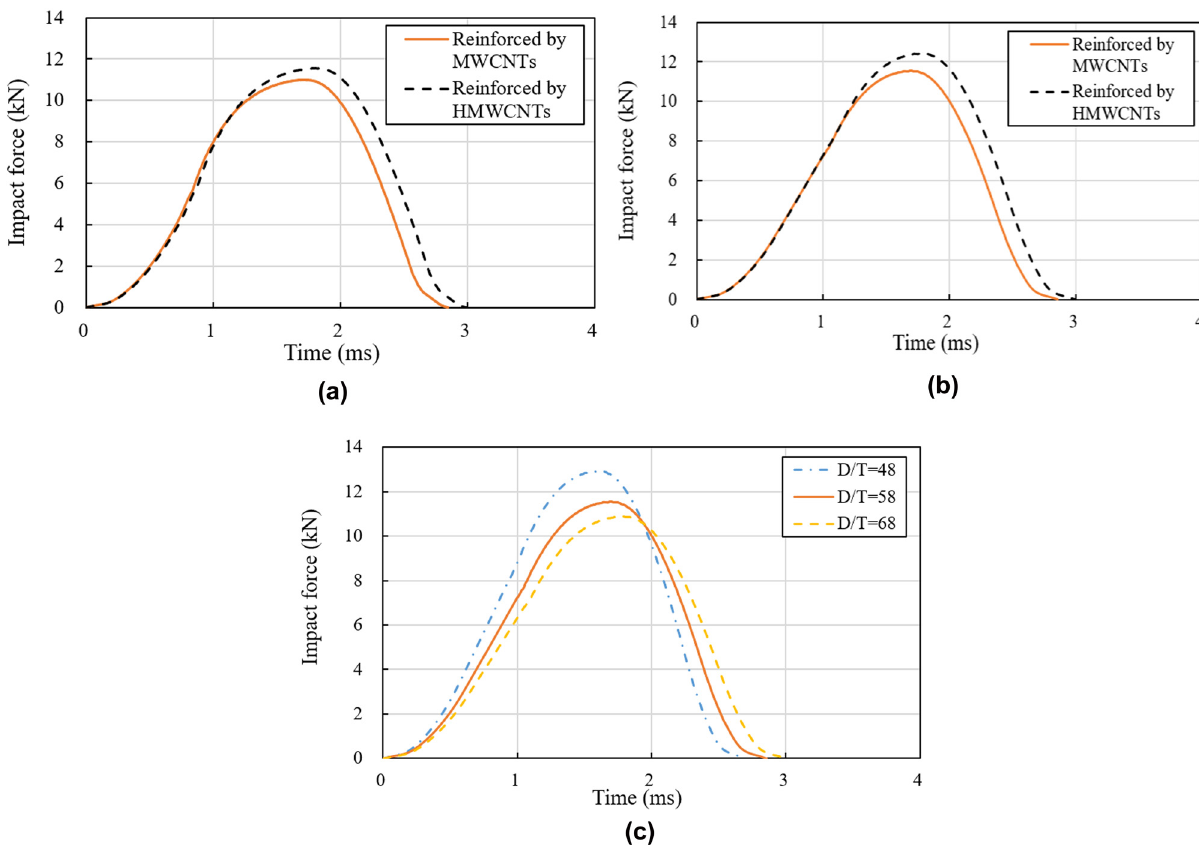
Figure 16: Parametric studies by veri fi ed FE model: ( a ) F70MC0.6M - I reinforced by di ff erent CNT types, ( b ) F70MC1.2M - I reinforced by di ff erent CNT types, and ( c ) F70MC1.2M - I with di ff erent diameter - to - thickness ratios ( D/T )